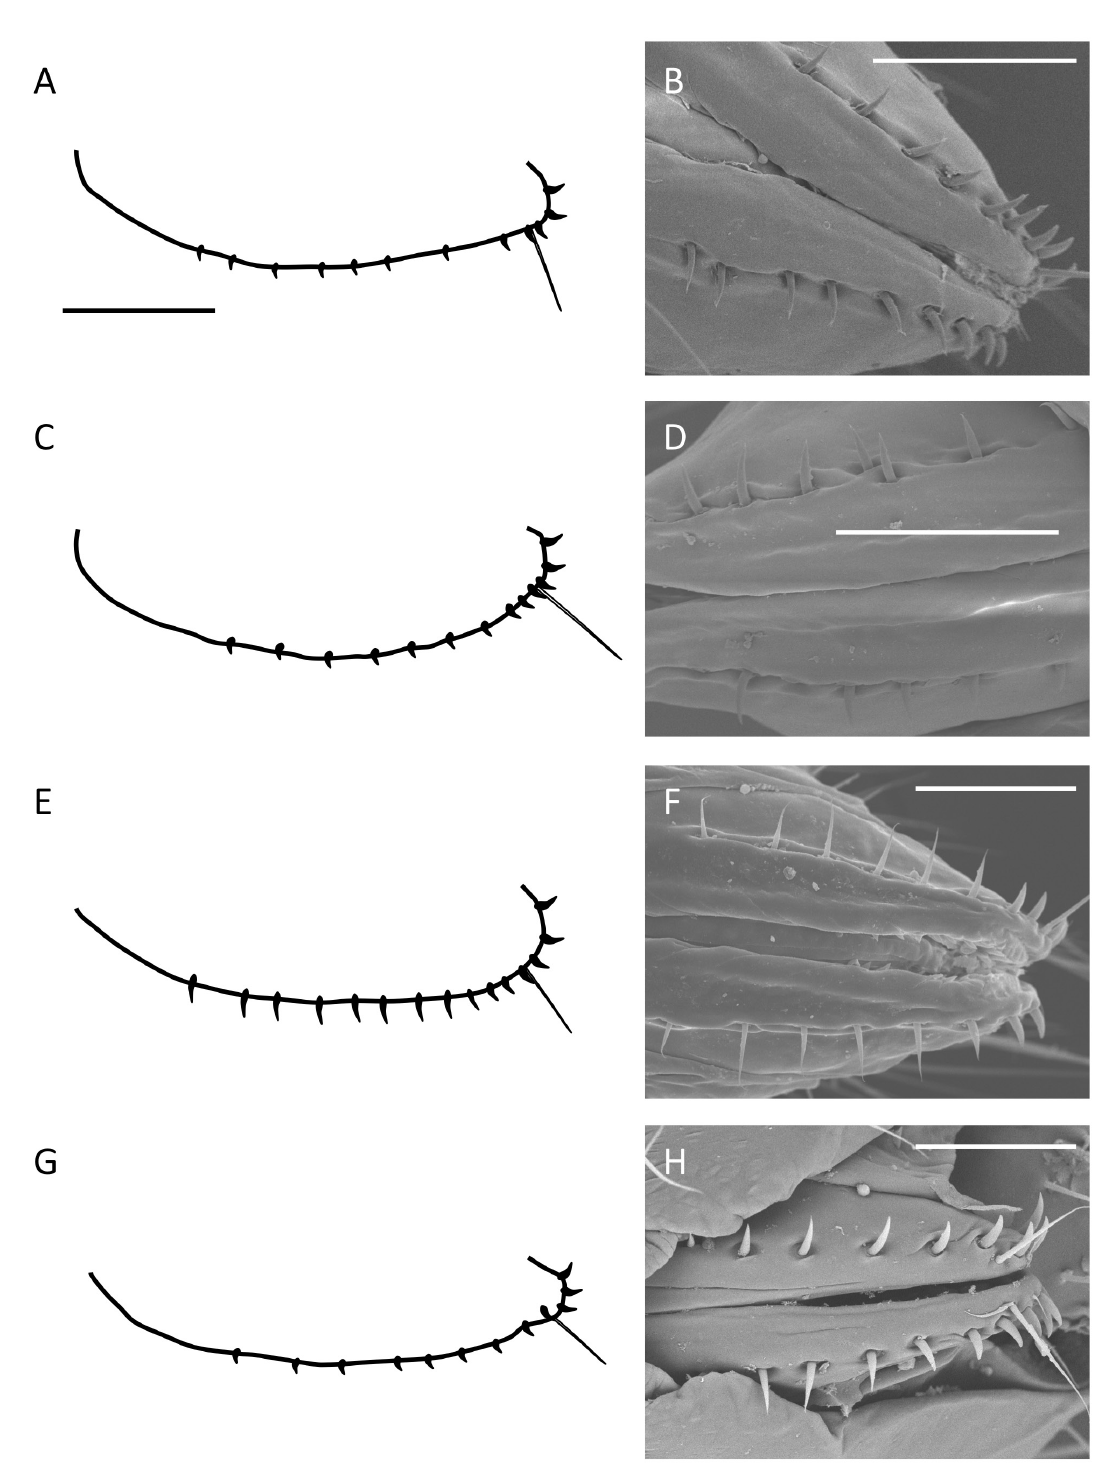
Fig. 6. Female oviscapts of the ‘ D. seguyi species complex’. A – B . D. seguyi Smart, 1945 (MNHN). C – D . D. malagassya Tsacas & Rafael, 1982 (MNHN). E – F . D. curta Chassagnard & Tsacas, 1997 (MNHN). G – H . D. chocolata Yassin & David sp. nov. (MNHN). Scale bars: A, C, E, G = 100 µm; B, D, F, H = 50